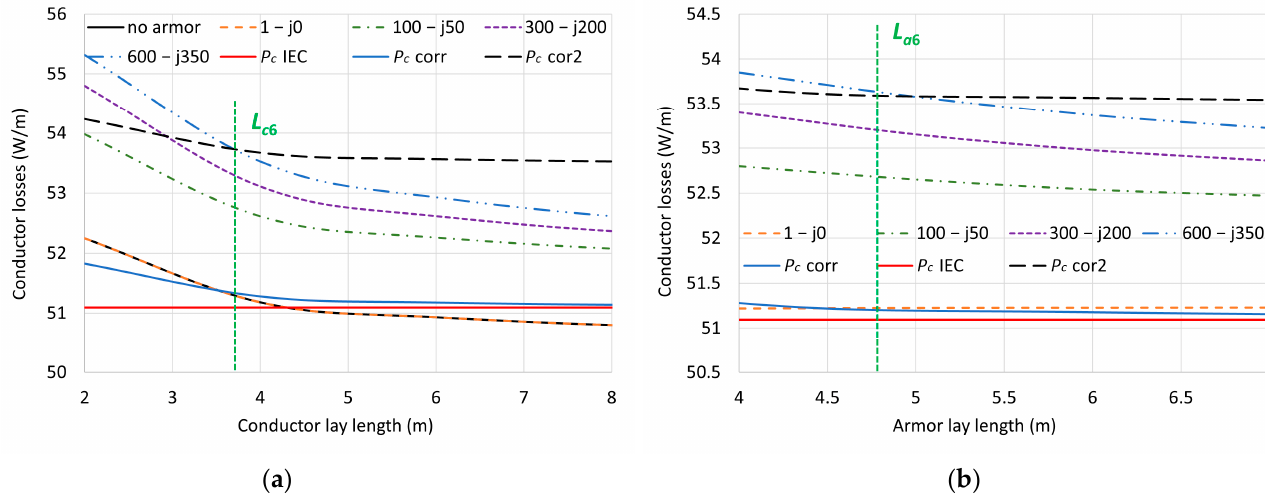
Figure 11. Variation of conductor losses with the armor permeability and ( a ) the conductor twisting or ( b ) the armor twisting in Cable 6 (SB). L c 6 ( L a 6 ): actual conductor (armor) lay